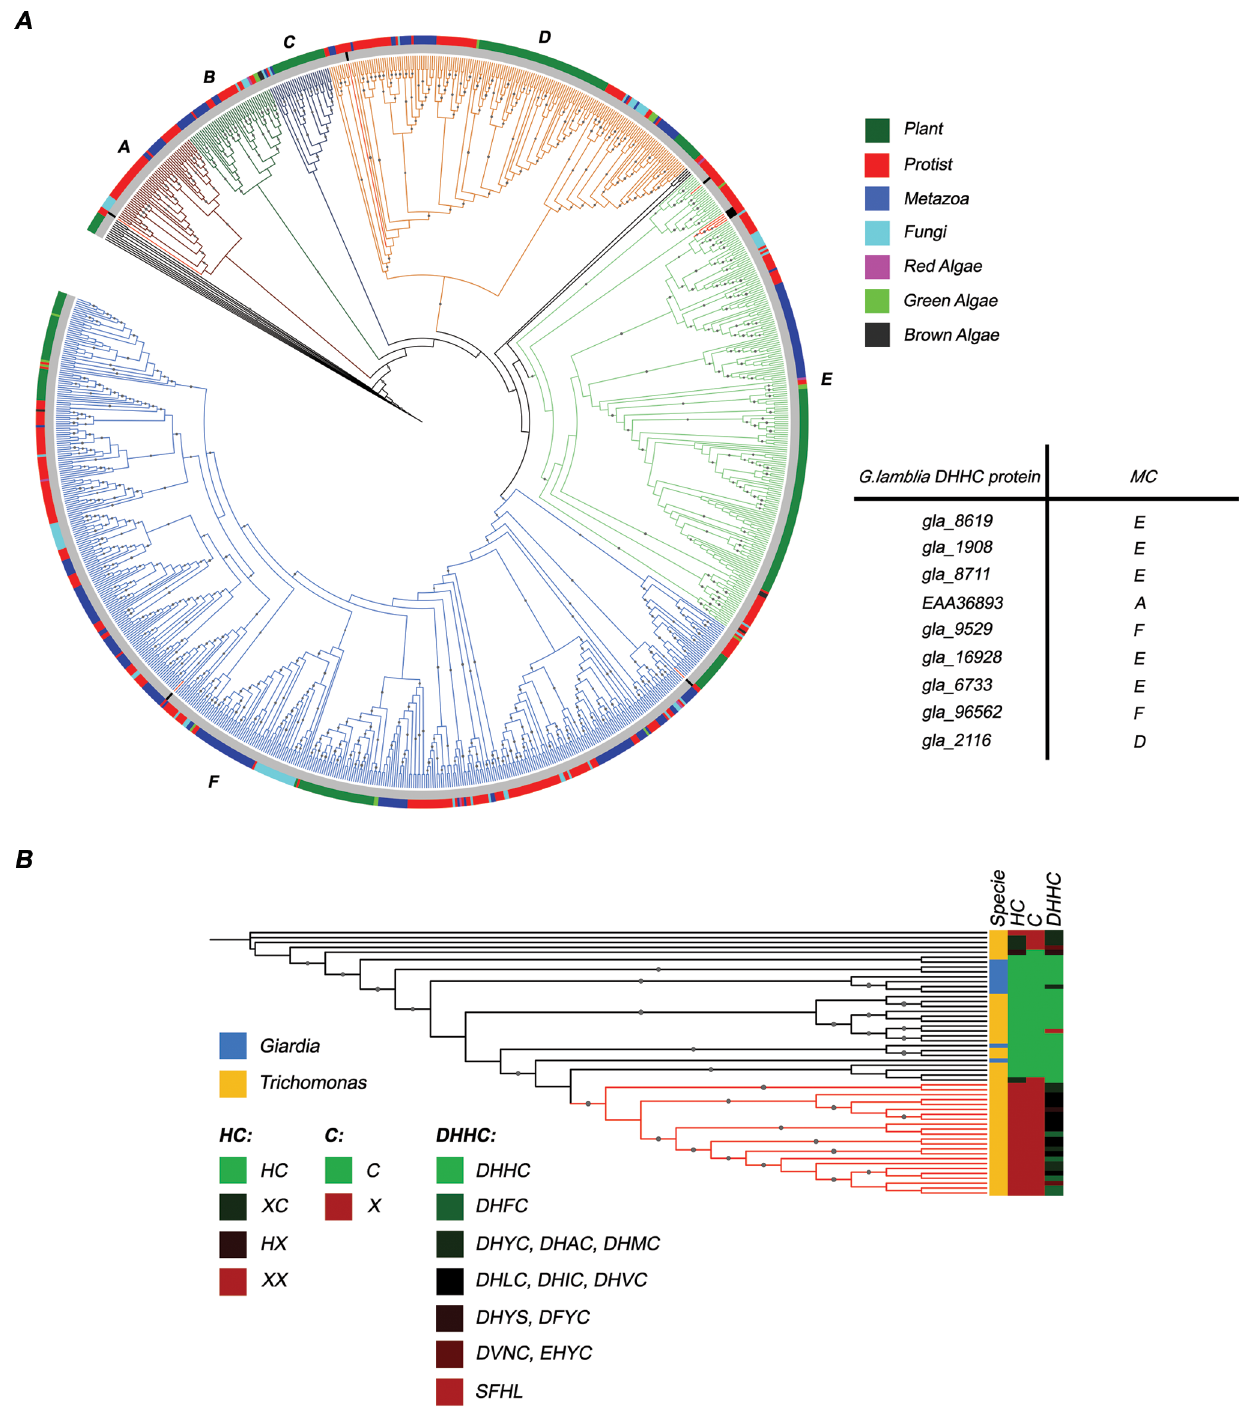
Figure 4. Phylogeny of DHHC proteins. (A) Phylogenetic relationships between DHHC proteins from Giardia and several other species. Phylogenetic tree of DHHC proteins inferred from ML analyses is depicted in the left panel. Symbols correspond to aLRT values . 0.7. Sequence taxonomic identity is displayed with colors (outer circle around the tree), as shown in the upper right panel. MCs are labeled as A, B, C, D, E and F. Giardia DHHC proteins are colored in red and indicated in black in the inner circle around the tree. Each Giardia DHHC protein position in the tree (MC) is indicated in the table (lower right panel). (B) Trichomonas duplicated DHHC sequences accumulate mutations. Giardia DHHC proteins are indicated in light blue, and Trichomonas DHHC proteins in yellow. Variations in the HC, C, and DHHC portions of the DHHC-CRD domain were mapped in the tree using a green-to-black-to-red color code. Full conservation is depicted in light green, while lack of conservation is shown in red. A clade of highly mutated Trichomonas sequences is displayed in red.